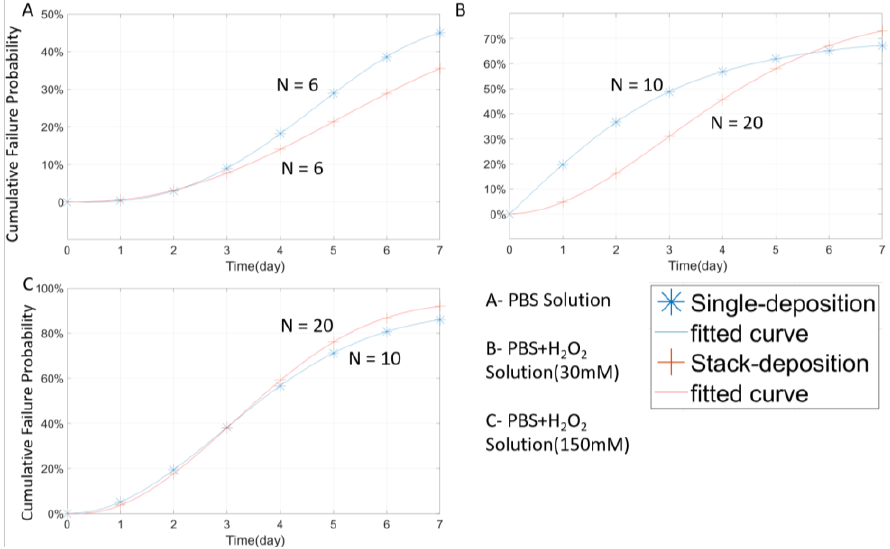
Figure 13 . The Weibull cumulative distribution data and corresponding curve fitting of the closed-tip samples with stacked-deposition (1 µm + 1 µm + 1 µm) and single-deposition (3 µm) of PA under the same thickness. Experiments were performed in different solutions at 67 °C.